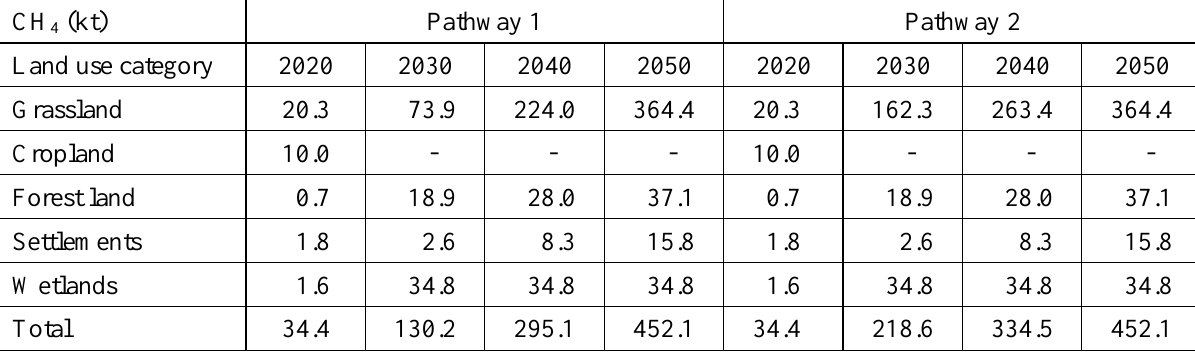
Table A2. CH 4 emissions (in kt) from land use on organic soil in Germany under the proposed emission reduction pathways 1 and 2 (for details, see text).